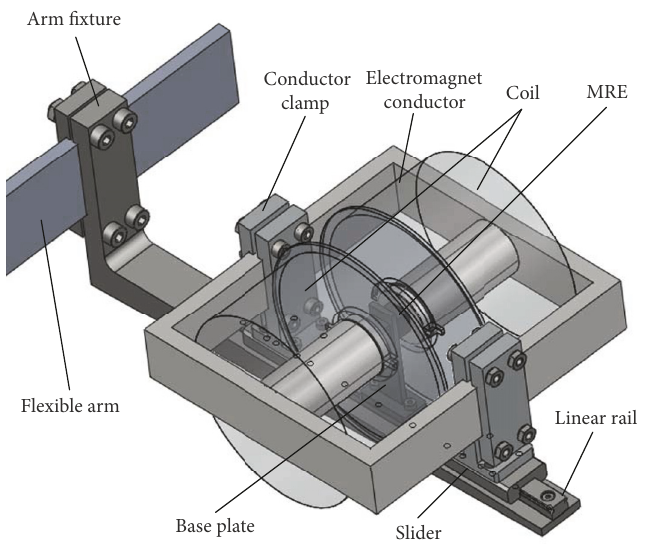
Figure 16: Scheme of the MRE vibration